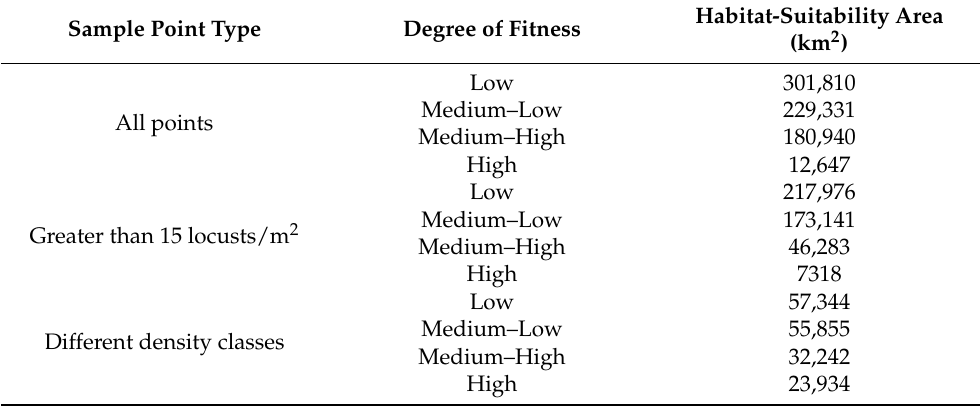
Table 5. The results for the habitat-suitability areas for grassland locusts under different